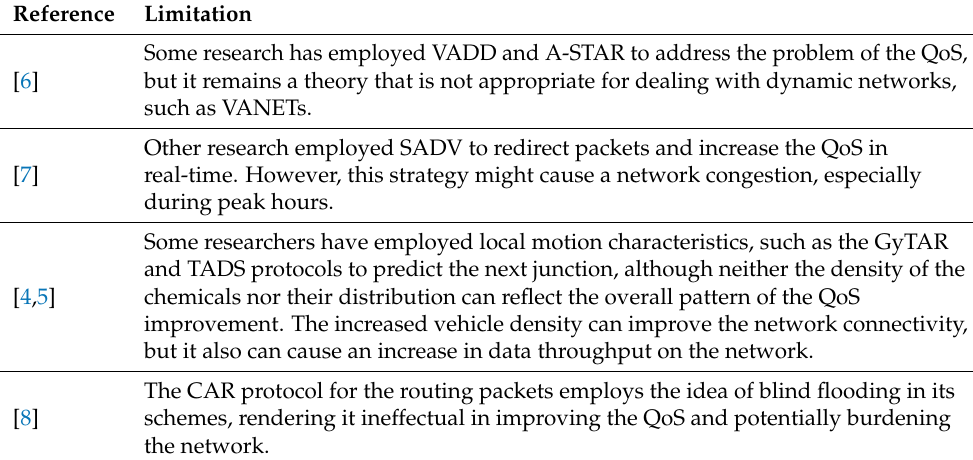
Table 1. The prior studies along with their